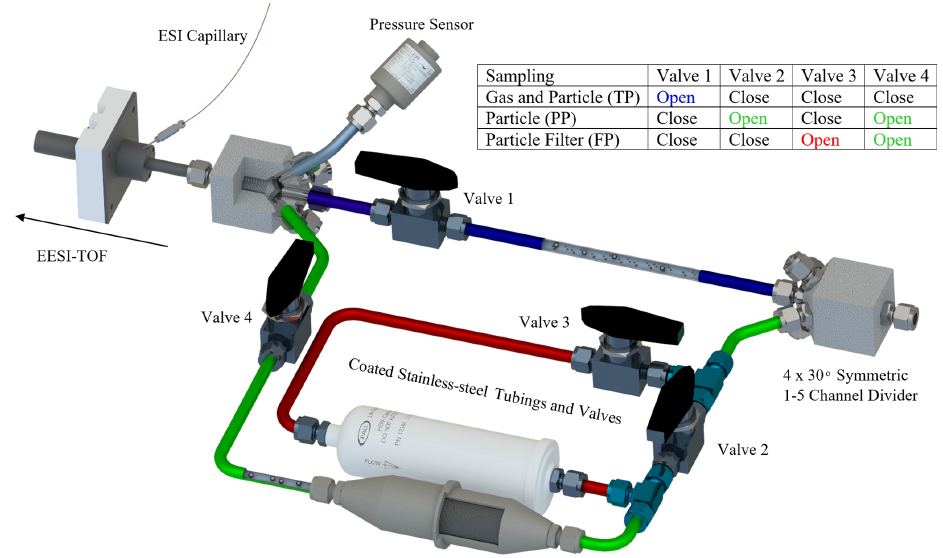
Figure 1. Schematic diagram of the developed ionization inlet for the Dual-EESI. The inlet consists of the following channels: total phase (TP, shaded blue), particle phase (PP, shaded green) and particle filter (FP, shaded green and red). The gas-phase measurement is obtained as TP–PP, whereas the particle-phase measurement is obtained as PP–FP 2